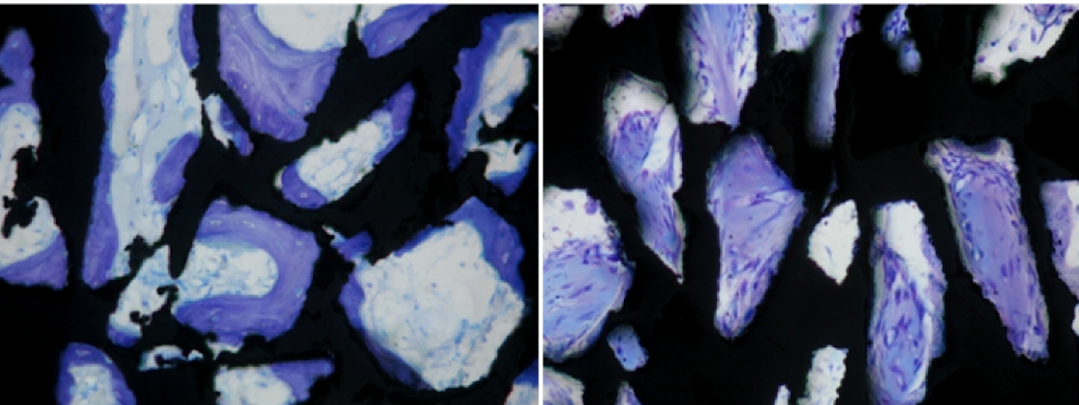
Figure 8. Bone in-growth into the pores: a) at 4 weeks showing partial filling, b) at 8 weeks showing increase of bone